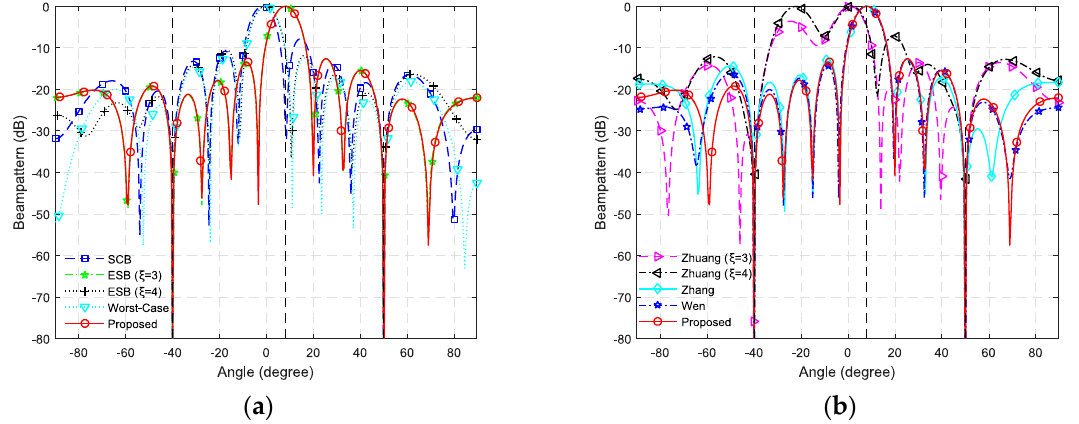
Figure 3. The resultant beampatterns for SNR = 0 dB. ( a ) The beampatterns of SCB, ESB, Worst-Case and the proposed beamformer; ( b ) The beampatterns of Zhuang’s, Zhang’s, Wen’s and the proposed